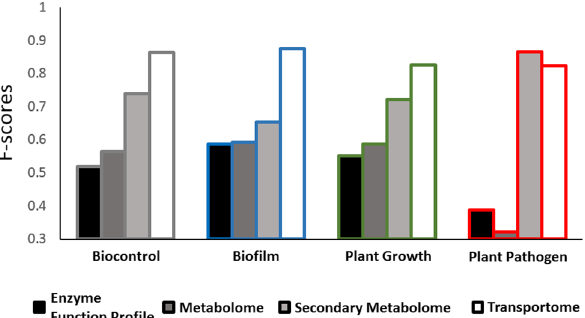
Fig 3. F-score for SVM predictions of ecological niche by input data type. Predictive capacity of SVM models is function of input type used to train model (enzyme profile, metabolomic, secondary metabolism or transportomic) and ecological niche in the rhizosphere (biocontrol, biofilm, plant growth promoter, or plant pathogen). Environmental niche classes were assigned at a confidence of > = 95%. F-scores are calculated from Leave One Out Validation